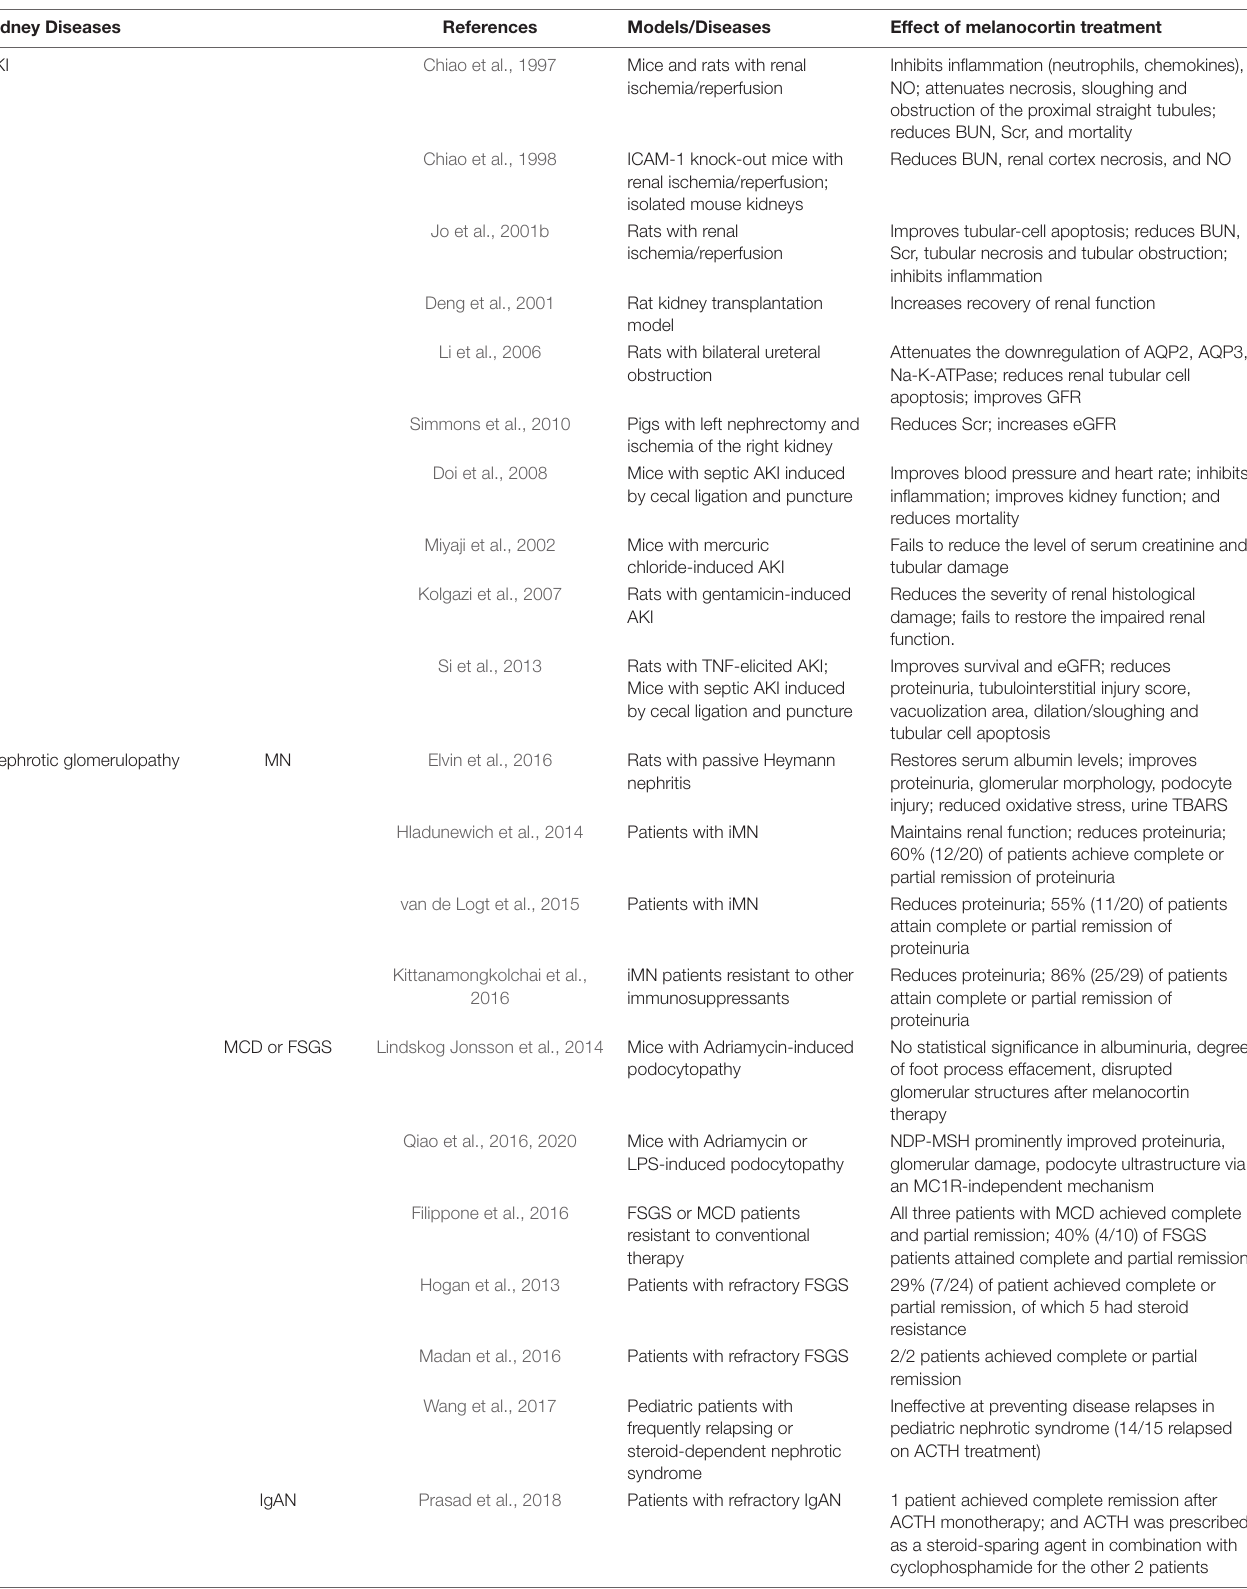
TABLE 2 | The effect of melanocortins in kidney